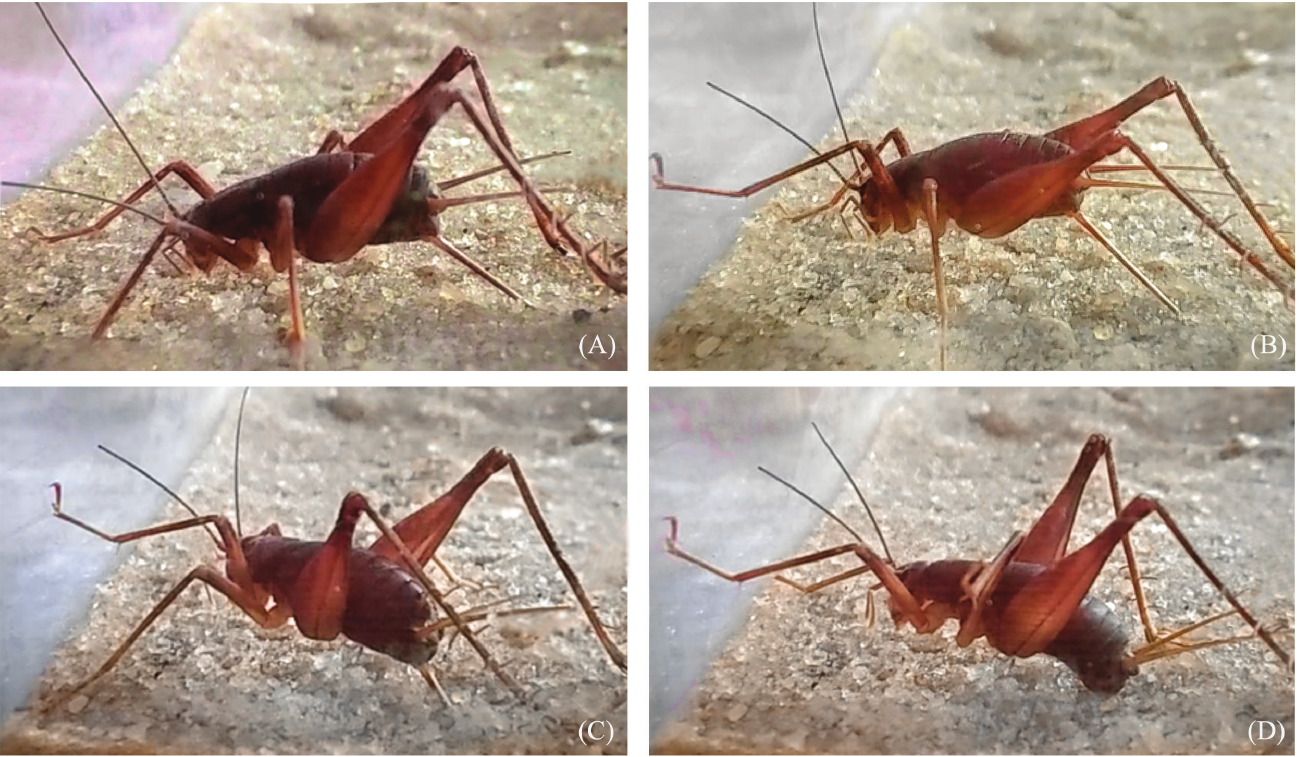
Fig. 3. Endecous chape oviposition behaviors. A . Female pressing the tip of ovipositor against the sand surface at a 40° angle; B . Female redirecting the ovipositor at another angle (about 70°); C . Female burying the ovipositor; D . Female with the ovipositor penetrated, remaining